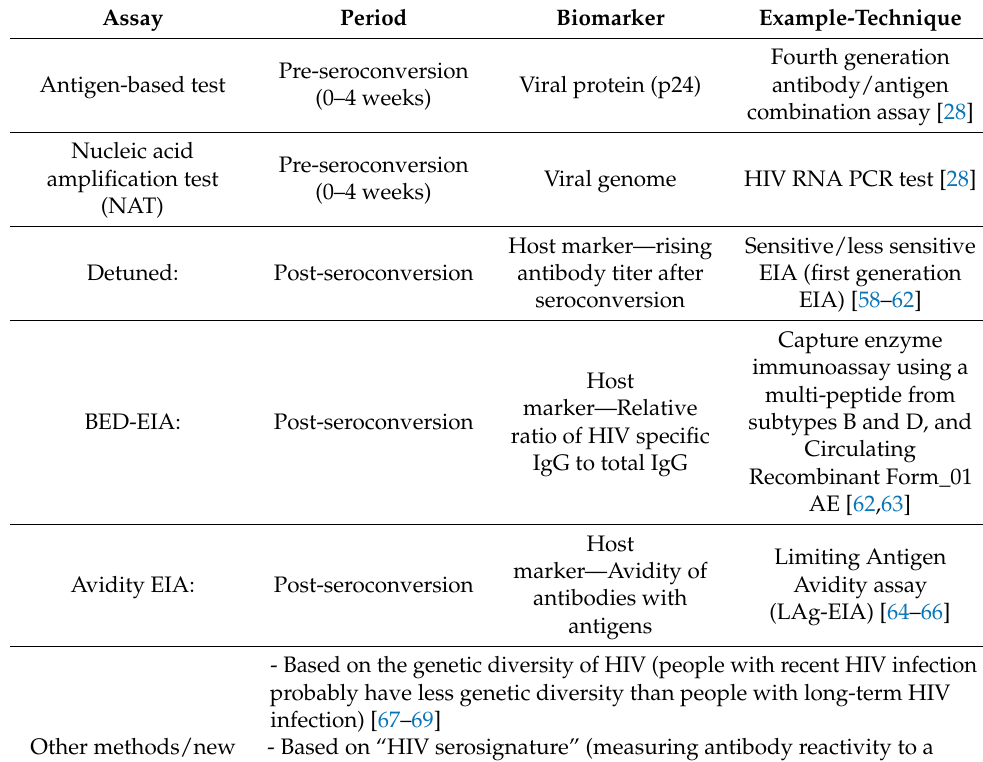
Table 1. Assays that have been used for the detection of recent HIV